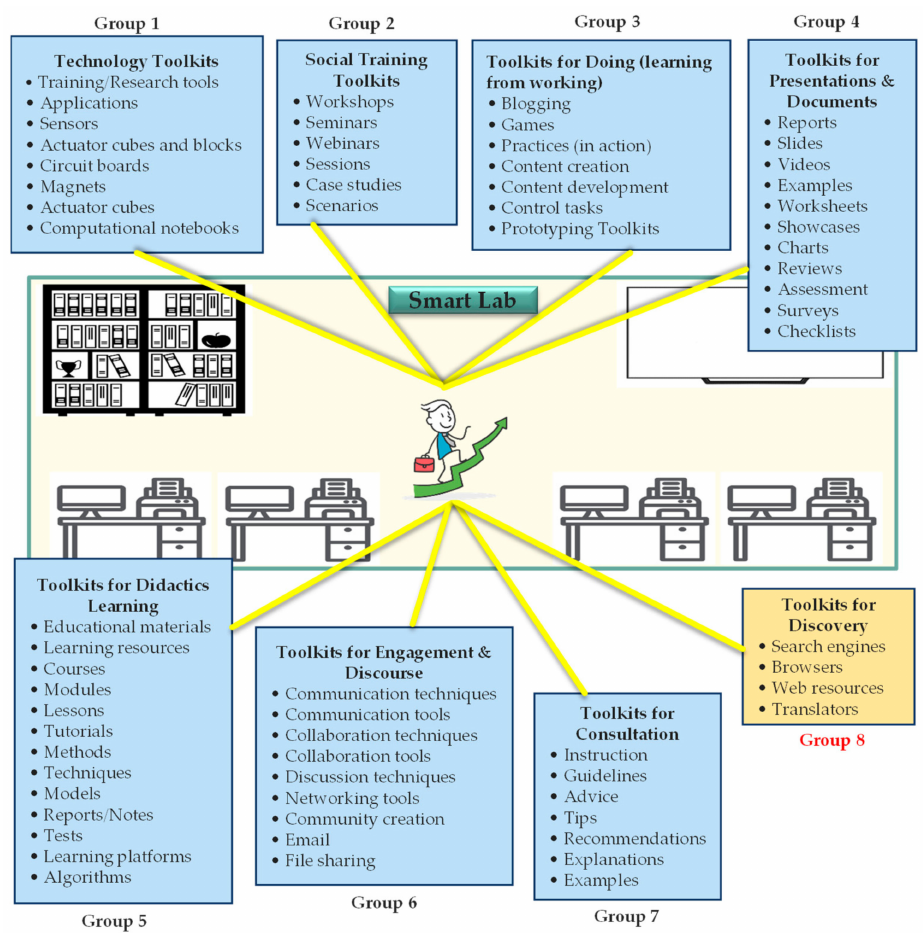
Figure 3. Proposed conceptual model for creating a package of training Toolkits in the Smart Labs.